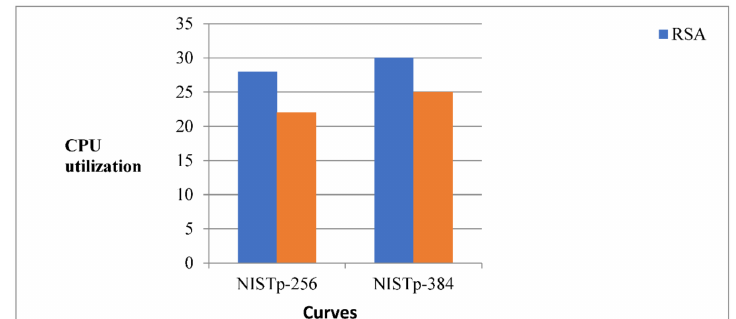
Figure 16. CPU Utilization of RSA and ECDSA.